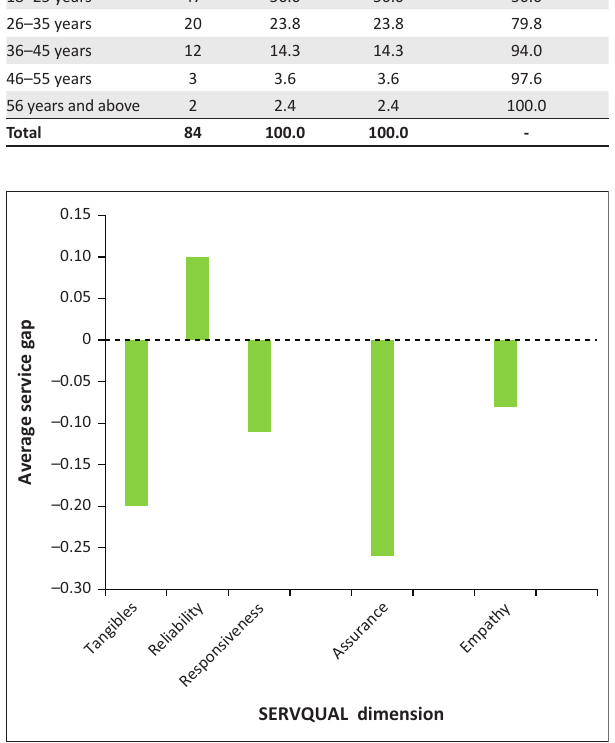
FIGURE 2: Average service quality gap of the SERVQUAL dimensions experienced by Gautrain users ( n = 84).